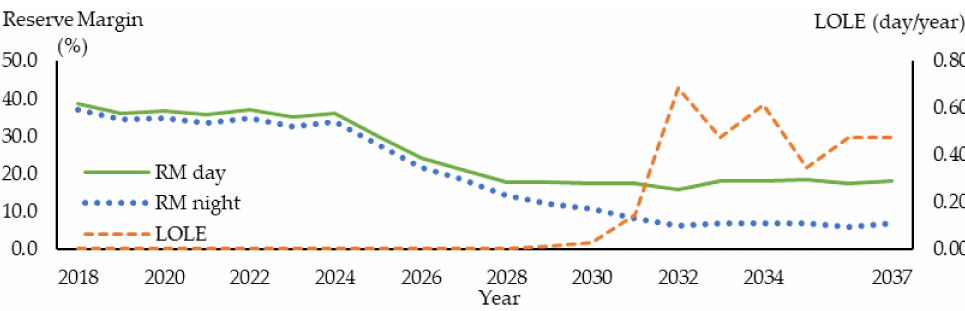
Figure 11. Reliability indices of the generation expansion plan with LOLE < 0.7 day/year